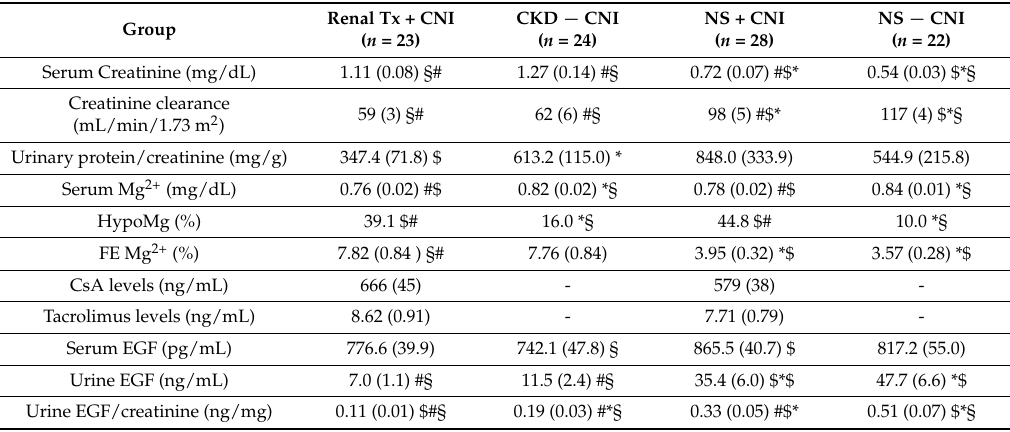
Table 2. Urine and serum analyses; data are presented in 4